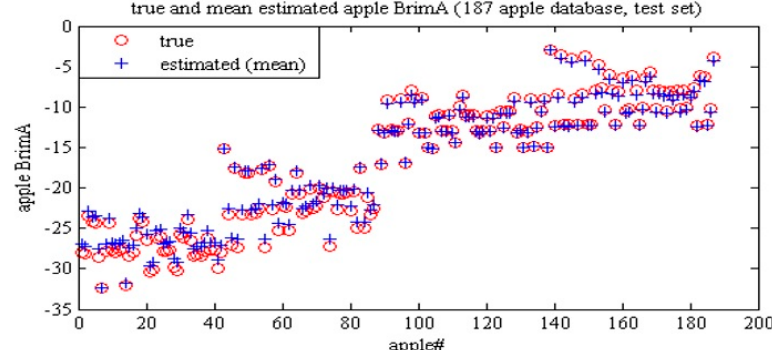
Figure 6. Measured values versus the mean estimated values of BrimA property for the test set. Each iteration contains 56 test samples; hence, there are 56,000 samples at 1000 iterations, and since there are only 187 samples, there are more than 299 iterations in each sample and their mean is calculated.